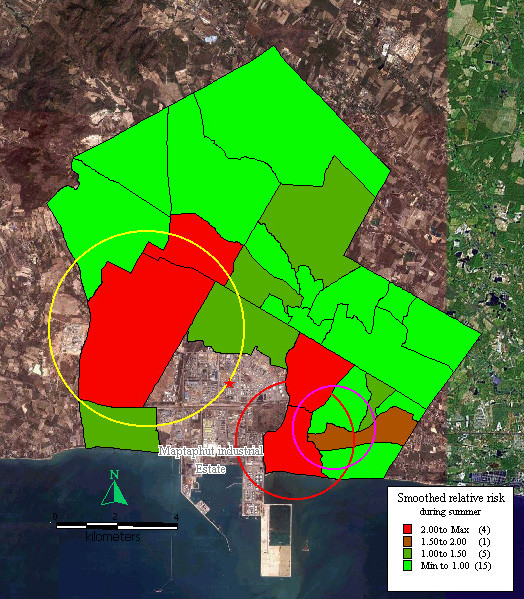
Mapping of smoothed relative risk and disease clusters in the study area during summer. Red circle indicates the first cluster of respiratory disease that includes Takuanaupradoo, Koakoknongtungmae and Nongnamyen. Yellow circle indicates the second cluster of respiratory disease that includes Mapchalood, Taladhauypong and Watsopol. Magenta circle indicates the third cluster of respiratory disease that includes Koakoknongtungmae, Nongnamyen and Takuanaupradoo. Red star sign indicates weighted mean centre of the stacks.